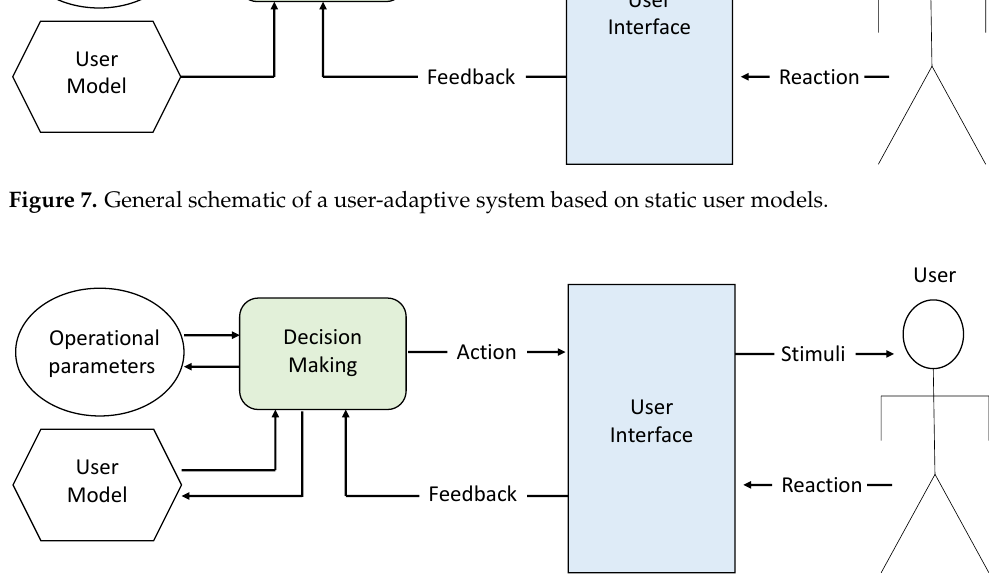
Figure 8. General schematic of a user-adaptive system based on dynamic user models. The user’s feedback reactions are used to continuously update robot knowledge and consequently tune the system’s